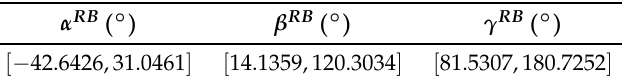
Table 2. Ranges for the joint angle of the right back leg.